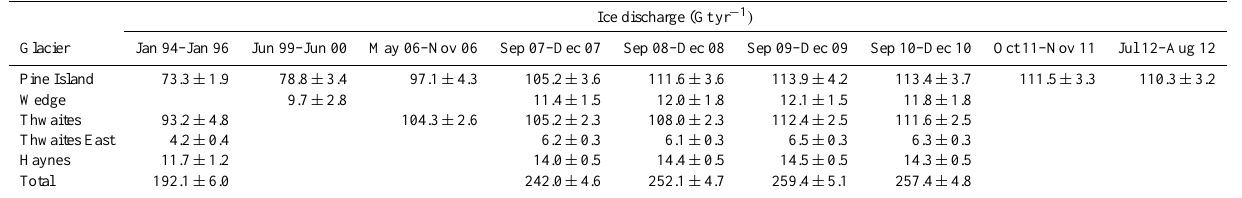
Figure 9. The elevation-dependent accumulation distribution for Thwaites glacier catchment (including the Thwaites East and Haynes) and comparison with climatologies and reanalysis and climate models. For each part, the grey shaded area shows the quantity of interest from our final accumulation grid including its ± 1 σ deviation. The climatologies and reanalysis and climate models do not have errors because the products do not provide error grids. The three part figure shows (a) the average accumulation rates over 100m elevation bins, (b) the bin-summed accumulation rates scaled by the cell size of 9km 2 with bars representing the bin size, and (c) the cumulative bin-summed accumulation rates from (b) . The solid vertical black lines on each plot display the elevation limits of our radar-derived accumulation measurements, and thus bound the area with high data integrity. Table 4. Flux-gate discharge measurements and errors from 1994 to